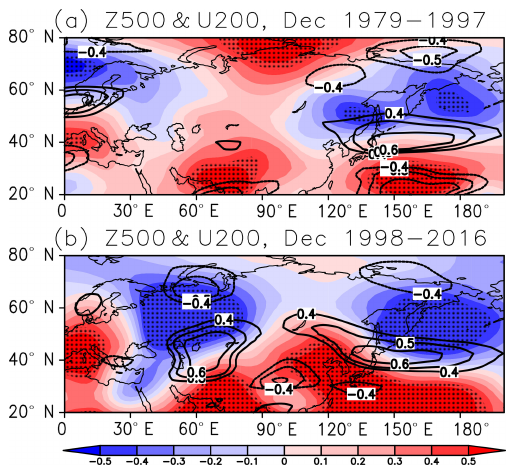
Figure 13. The CC between (a) I LS1 , (b) I LS2 and Z500 (shad- ing) and U200 (contour) in December. The black dots indicate the CC exceeded the 95% confidence level ( t test). The linear trend is removed. Table 2. The CC between the DHD CNC and I LS1 ( I LS2 ) . OS means “original sequence”, and “DT” means that the linear trend was re-